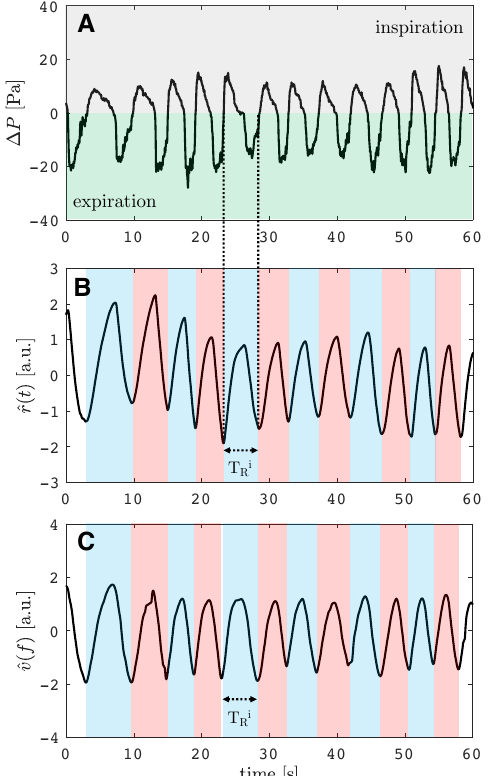
Figure 2. ( A ) ∆ P signal recorded by the reference instrument at the level of the nostrils. In grey, the signal collected during the inspiration (positive pressure), while in green, the signal recorded during the expiration (negative pressure). ( B ) Reference respiratory pattern signal (ˆ r ( t ) ) obtained from data processing of ∆ P signal. ( C ) Respiratory pattern signal obtained from the proposed measuring system ( ˆ v ( f ) ). Figure in ( B ) and ( C ) show similar patterns: during the inspiratory phase the signal increases, while during the expiratory phase they decrease. The duration of one breath ( T R ( i ) ) is shown on both the ˆ r ( t ) and ˆ v ( f )